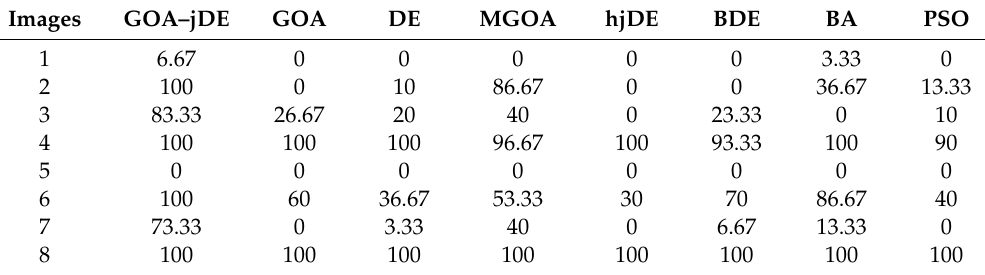
Table 6. The SSR values using MCE method compared with other